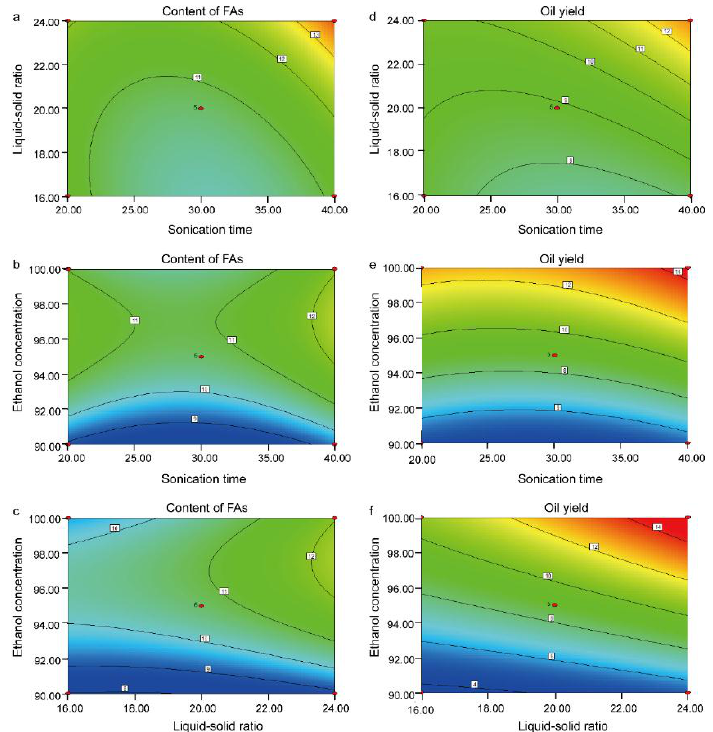
Figure 4. Contour plot for interactions between three independent variables on content of FAs (mg/g, a , b , and c ) and oil yield (%, d , e , and f ). Two variables were plotted against each other in each